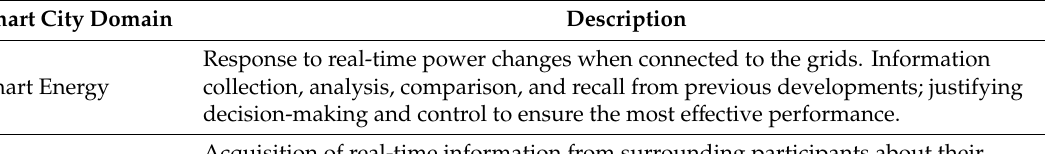
Table 6. Description of smart building–smart city integration by smart city domains. Smart City Domain